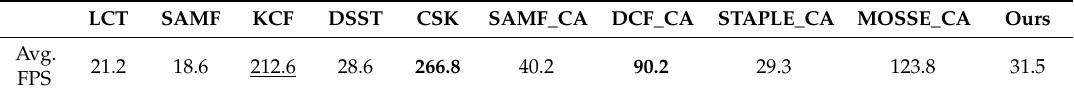
Table 1. The average speed of the proposed algorithm with comparisons to several state-of-the-arts CF based trackers carry on OTB-100 benchmark dataset. The best and second results are highlighted by bold and underline.